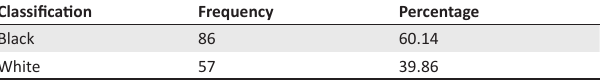
TABLE 6: Re-categorisation of race sample into black artisans and white artisans. Classification